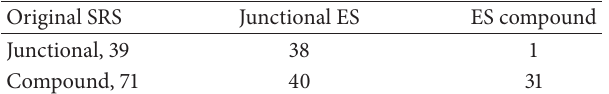
Table 2: Comparison between the features of the original SRS and